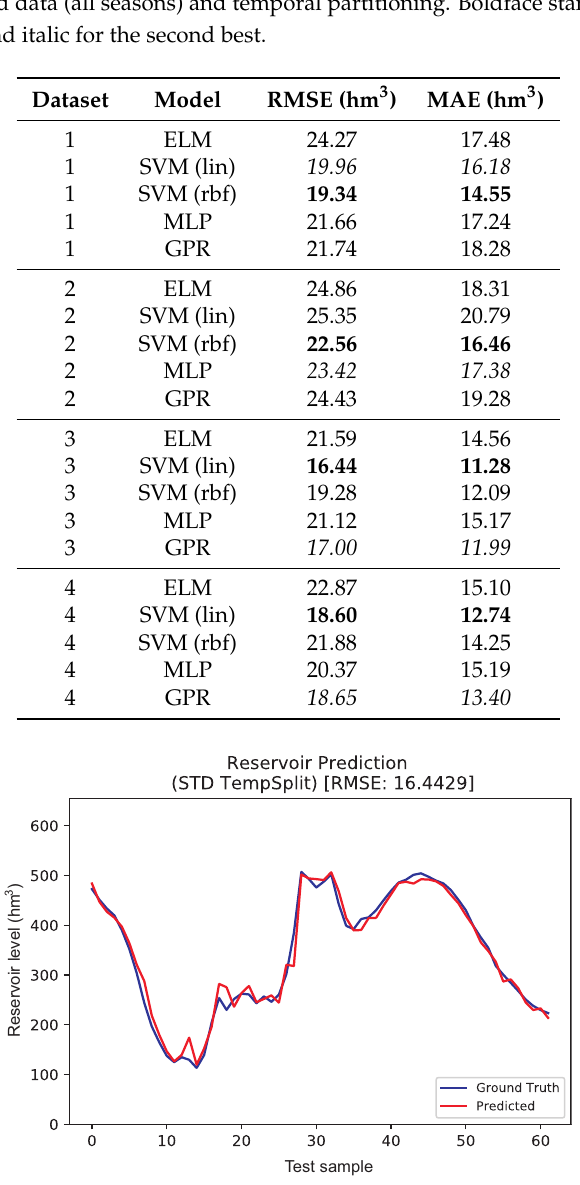
Figure 10. Ground truth vs. SVR predicted results for seasonal data, random partitioning